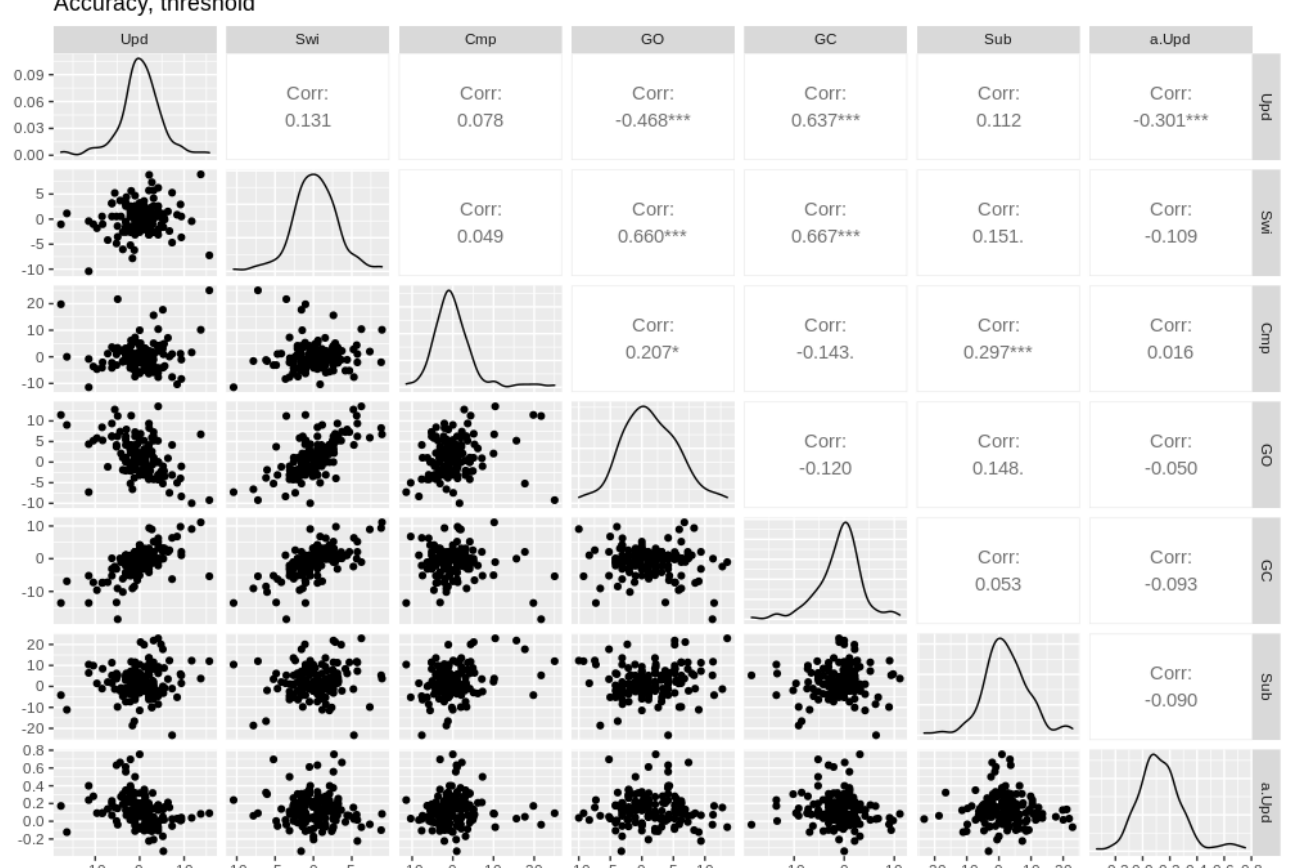
Figure A6. Pairwise Pearson correlations between threshold and accuracy cost effects. Empirical effects are shown in the first six columns. Parameter effects are shown in the last column (prefixed with the parameter name). Upd = updating, Swi = switching, Cmp = comparison, GO = gate opening, GC = gate closing, Sub = substitution. Asterisks * and *** denote p ‐ values of <0.05, <0.01, and <0.001, respectively.